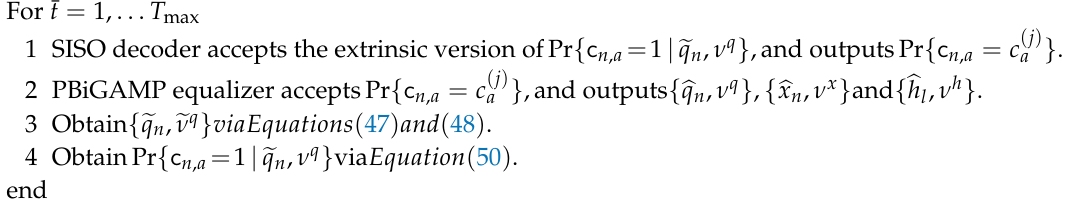
Box 2. The Proposed Joint Symbol-Detection, Channel-Estimation and Decoding Scheme. For ¯ t = 1, . . . T